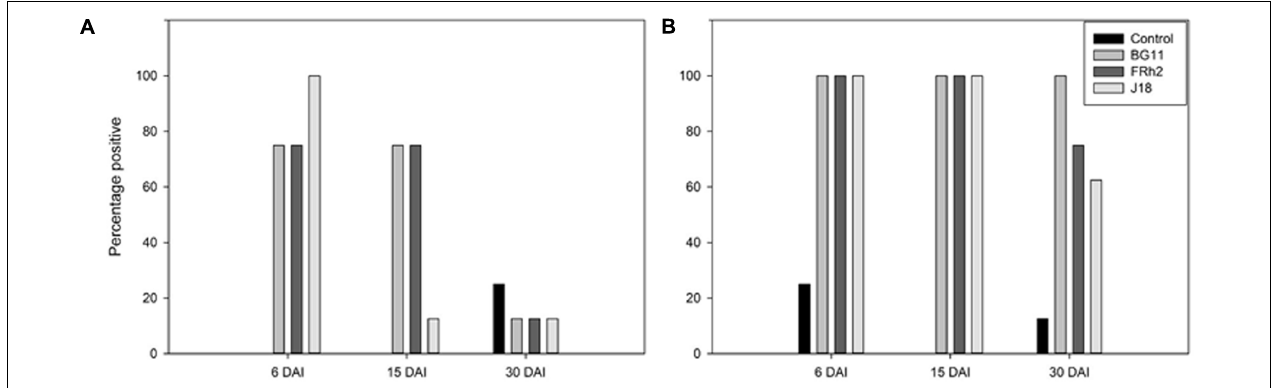
FIGURE 4 | Percentage of ef1 α Beauveria bassiana detected by PCR in rhizosphere soil (A) and on/in the root tissue (B) of Zea mays (maize) over three sampling events, 6, 15, and 30 days after inoculation (DAI) ( X axes). The number of positive samples were summed for each B. bassiana isolate treatment and control, and then calculated as percent present over samples ( Y axes).